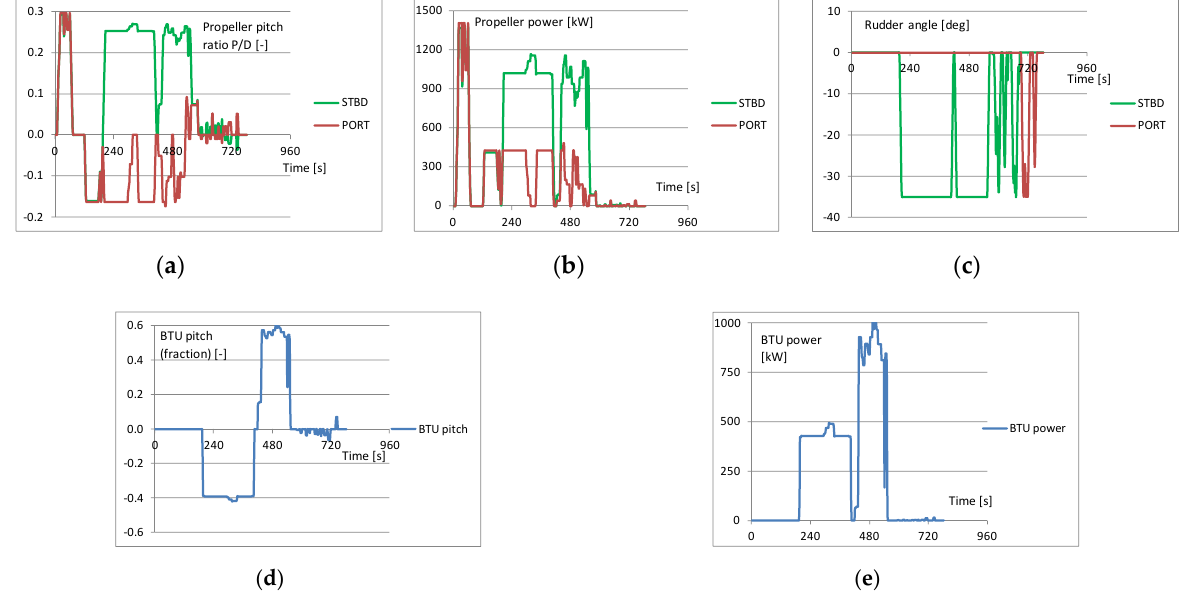
Figure 12. Representative time history of basic kinematic parameters of ferry test manoeuvre—joystick steering case ‘j/s #7’: ( a ) main propeller pitch ratios (–); ( b ) main propeller powers (kW); ( c ) rudder angles ( ° ); ( d ) BTU pitch (fraction of max., i.e., ∈ [ − 1; +1]); ( e ) BTU power (kW).